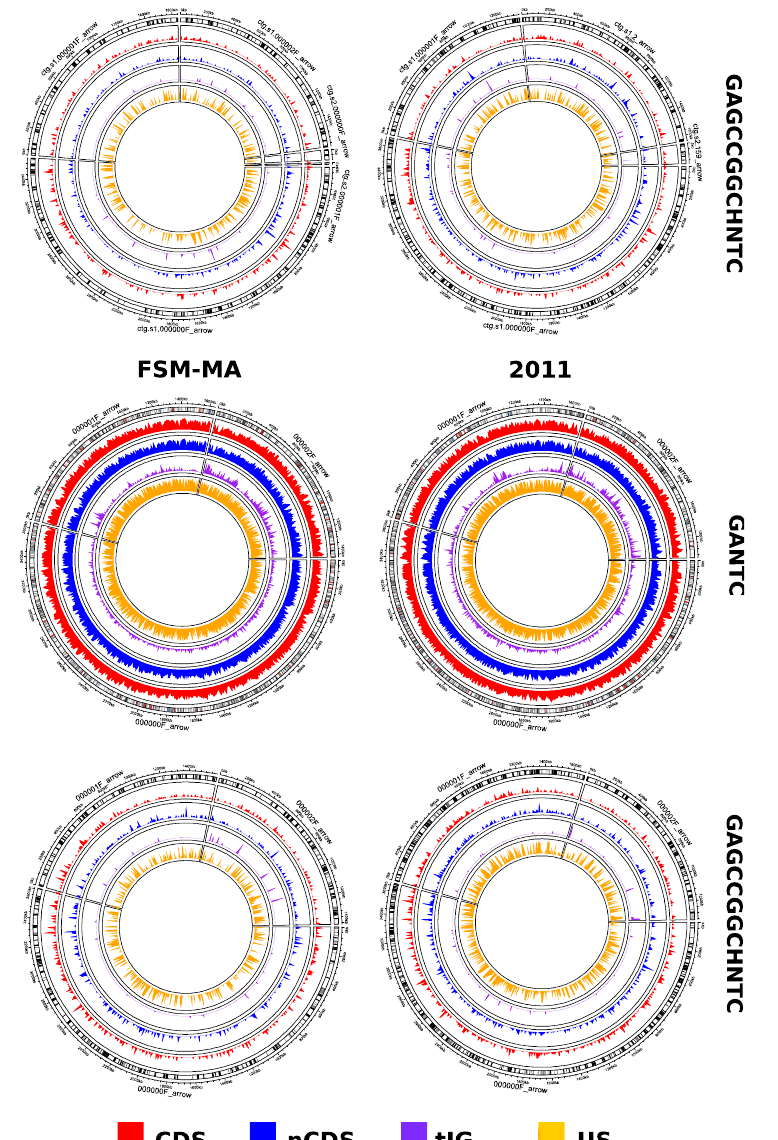
Figure 4. Circular density plots of GANTC and GCCCGGCH motifs in FSM-MA and 1021 strains of S. meliloti . The outer circle represents the genome annotation of the contigs of the strain (black lines indicate the position of CDS). Each inner circle represents a different category of methylated sites, CDS (red), nCDS (blue), tIG (purple), and US (yellow). The bars of each plot indicate the values for each category.